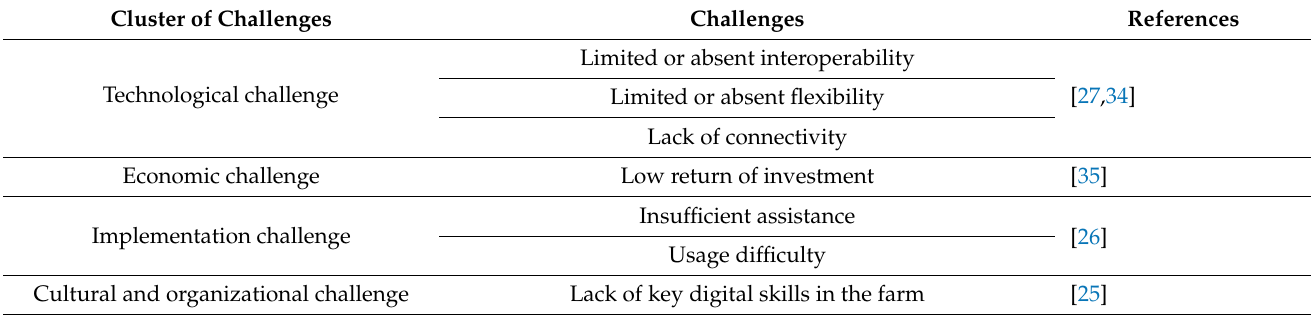
Table 3. List of